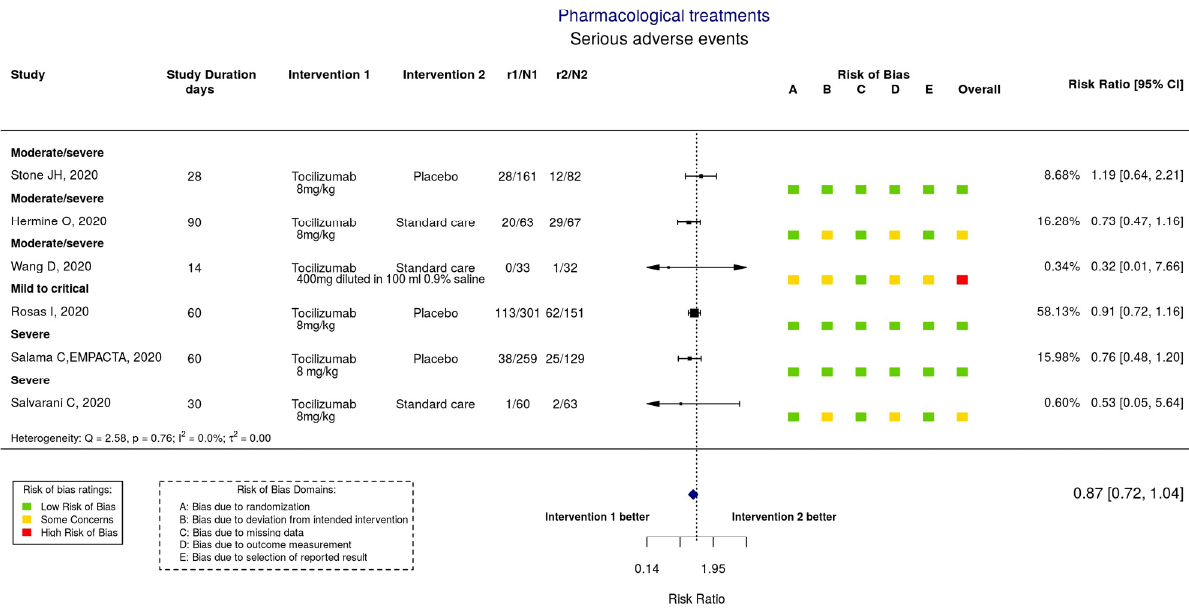
Figure 6. A forest plot comparing two interventions chosen by the user, in this case tocilizumab and placebo/standard of care. Taken from https://covid-nma.com/dataviz (accessed on 23 February 2021).